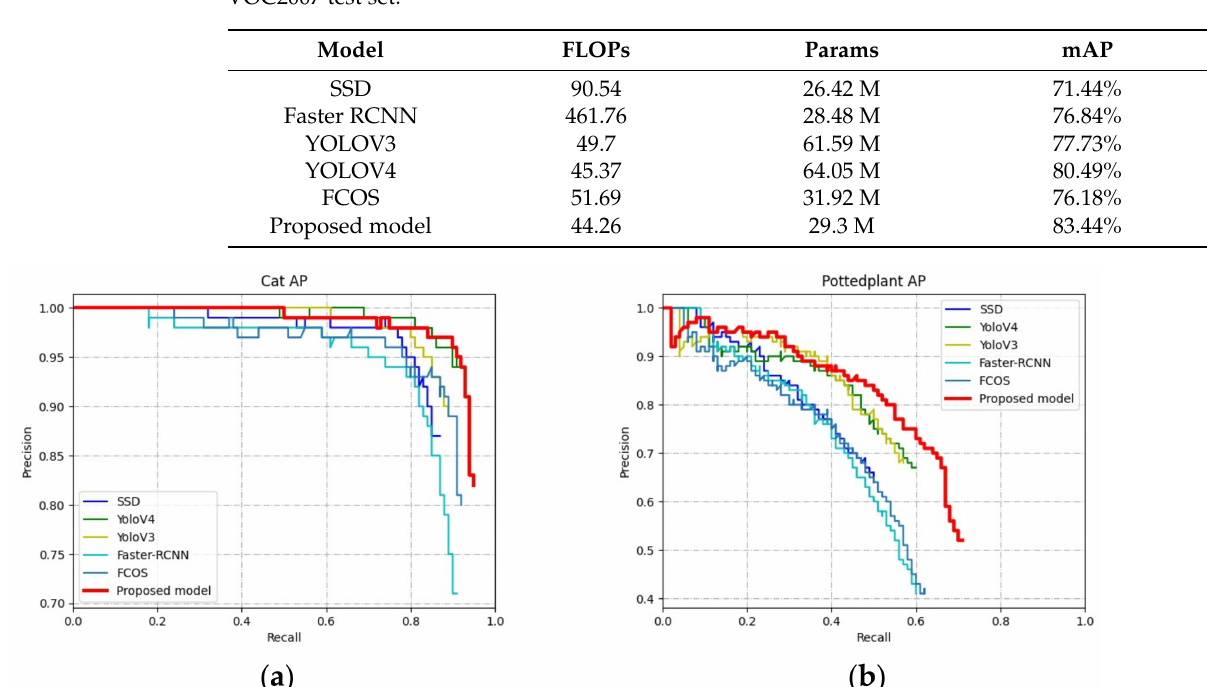
Table 2. mAP values, FLOPs and Params of the proposed model and other models on the PASCAL VOC2007 test set.